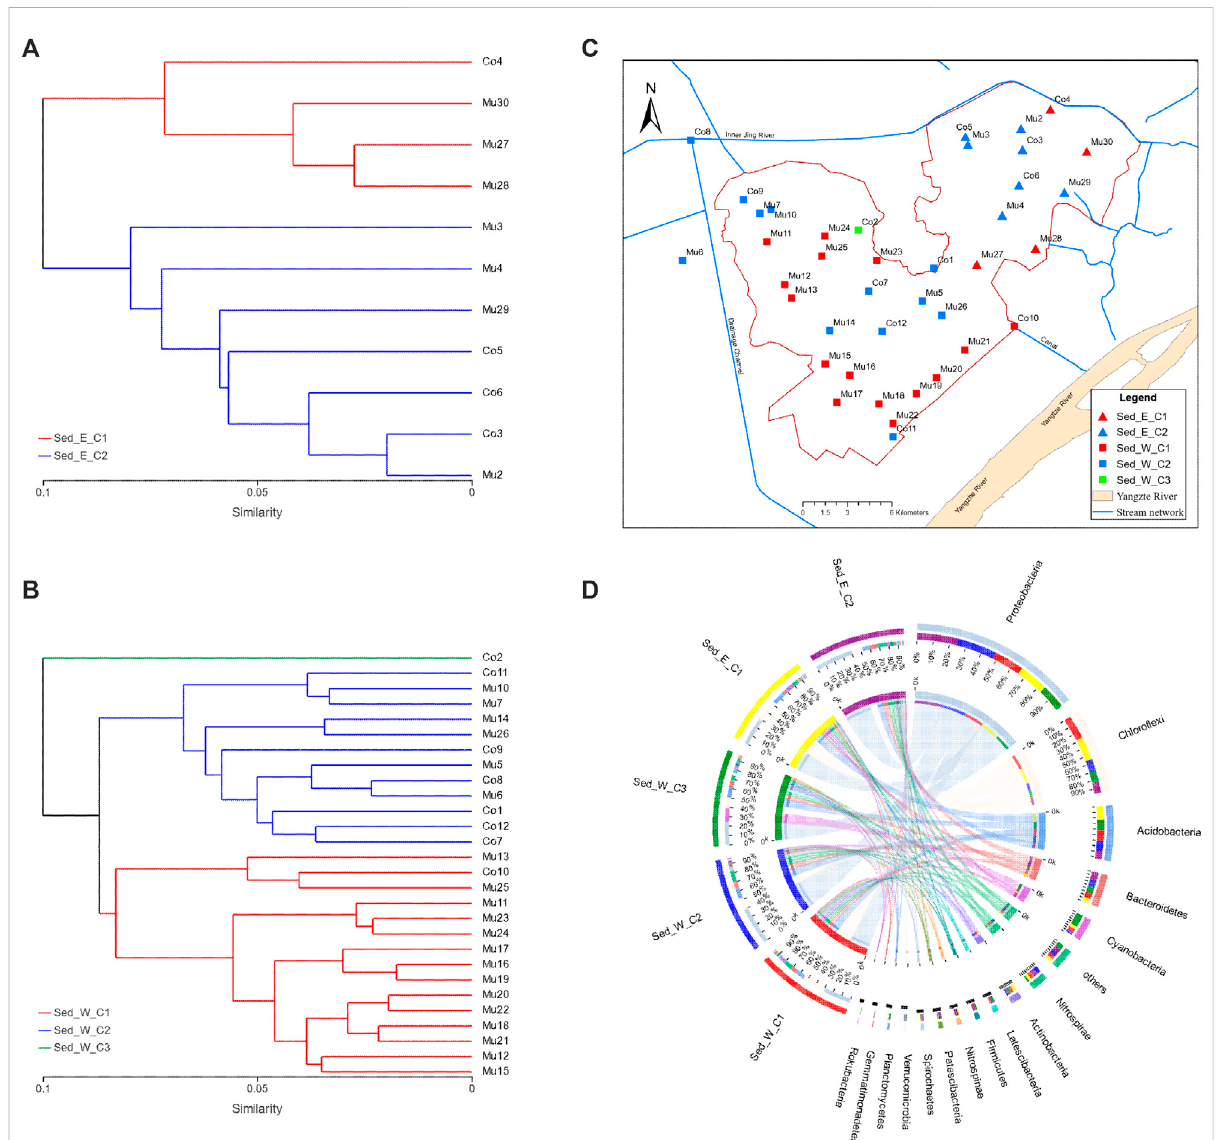
FIGURE 3 Clustering of sediment samples: (A,B) hierarchical clustering trees for sediment samples in the east and west divisions of the wetland, respectively, (C) distributionofsamplesinclustersshowingoverallsamplesalongtheedgeofthewetland(Sed_E_C1andSed_W_C1)andaroundthe center of the wetland (Sed_E_C2 and Sed_W_C2) belong to separate clusters in both the east and west divisions of the wetland. (D) Circos diagram for the sample and species relation for the fi ve clusters in (A,B) , the small semicircle (left semicircle) represents the species composition in the sample, The color ribbons of outer semicircle represents the sample groups, the color of the inner ribbon represents the species, and the length represents the relative abundance of the species in the corresponding sample; The outer semicircle on the right half indicates the distribution of the average proportion in different sample groups at the taxonomic level. The outer color band represents species, the inner color band represents different groups, and the length represents the distribution proportion of the sample in a certain